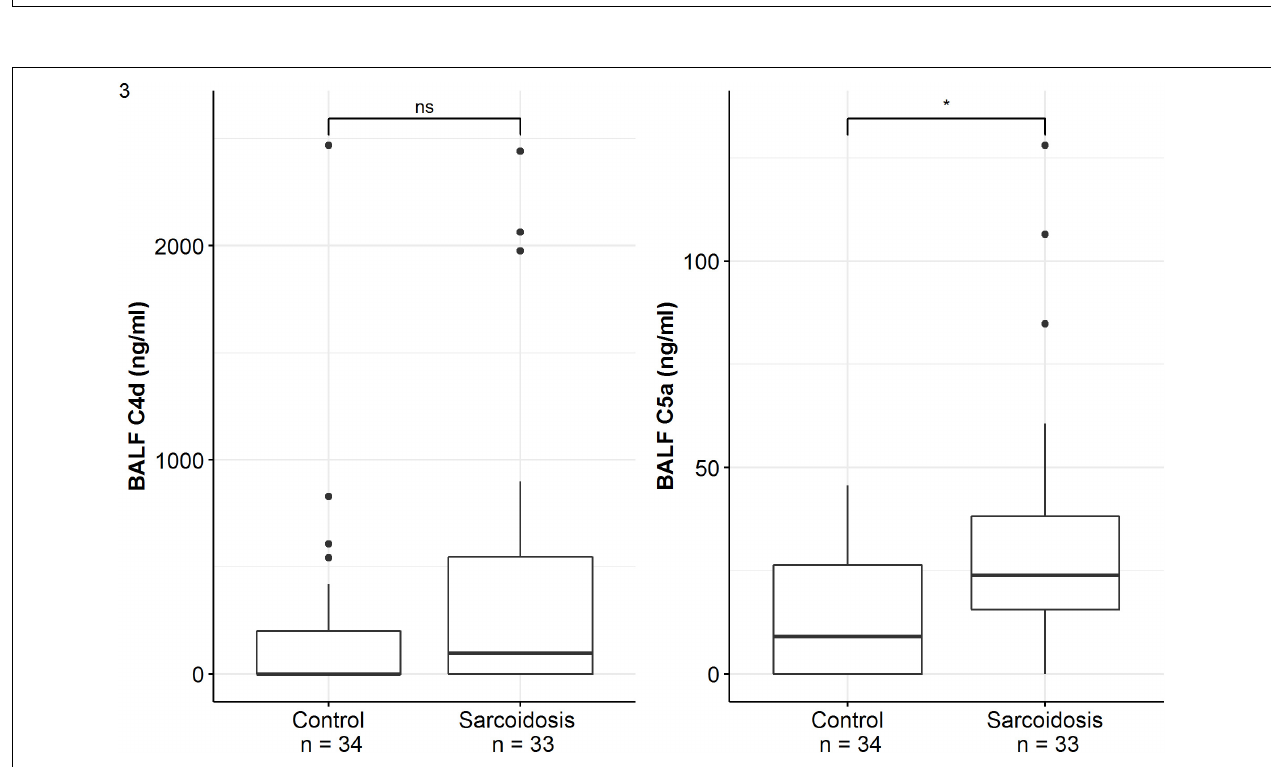
FIGURE 3 | BALF complement split products concentrations of sarcoidosis and control patients. Horizontal bars with a star denote statistically significant comparisons ( p -value < 0.05) whereas bars annotated with “ns” denote non-significant comparisons (Mann–Whitney U test).